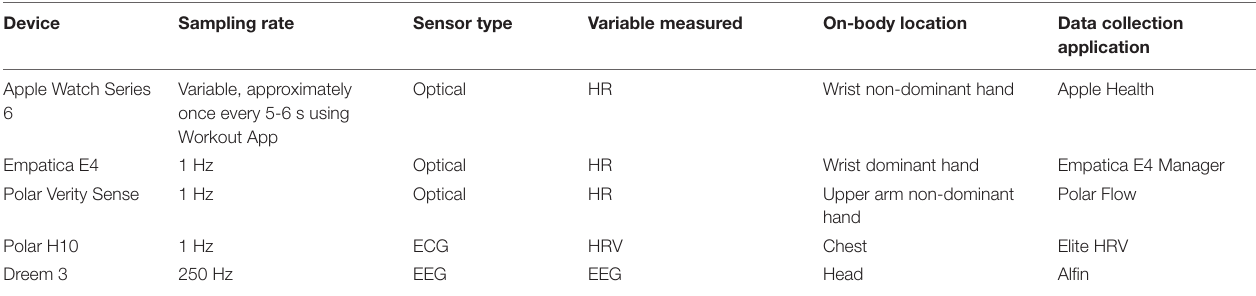
FIGURE 2 | A timeline of the different epochs of the TSST. Dashed lines indicate time points in the experiment when stress-related surveys are administered (indicated by a (cid:77) ) and/or when working memory assessments (SSPAN, OSPAN) are administered (indicated by a *). Wearable devices are recorded continuously from the start of the Baseline epoch to the end of the Recovery 2 epoch. Measures are aligned around the start of the Stress Induction Task ( T + 0min ). TABLE 1 | Features of the wearable devices to acquire physiological signals during a study